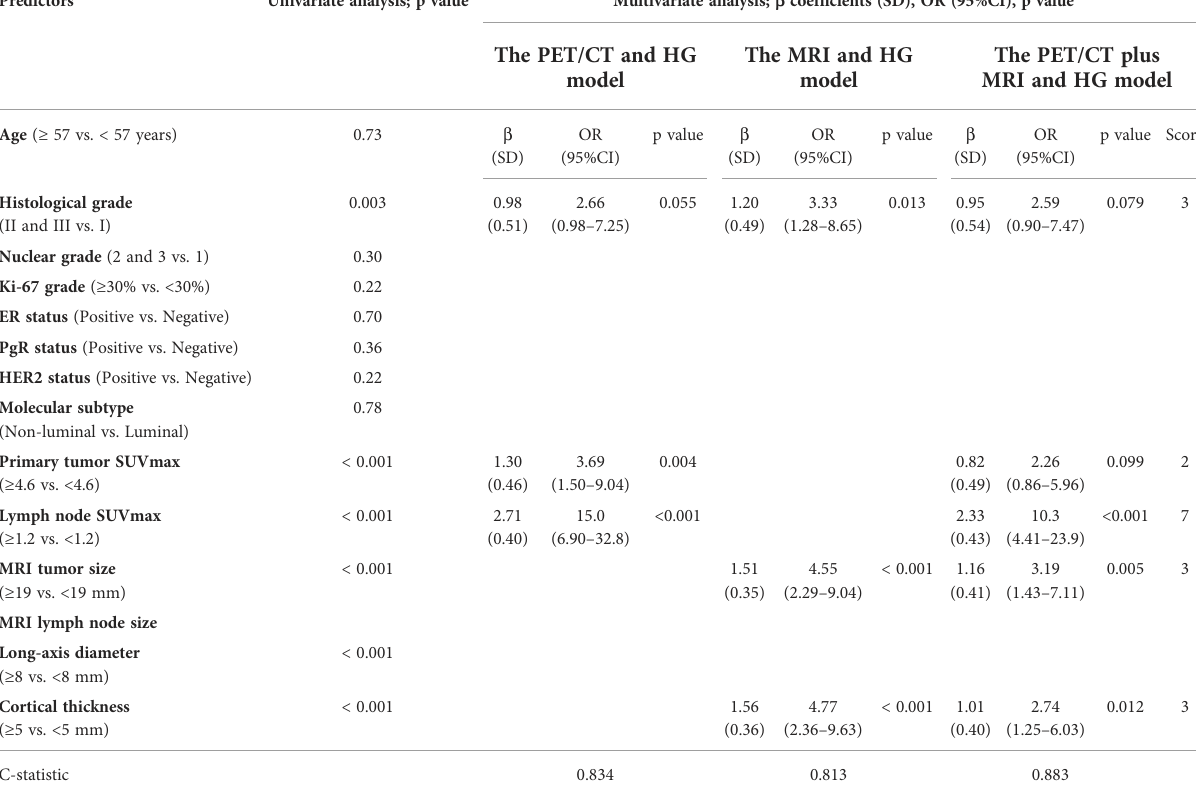
TABLE 2 Predictors of axillary lymph node macrometastasis in the PET/CT and histological grade, MRI and histological grade, and PET/CT plus MRI and histological grade models and score weights of the predictive variables in the PET/CT plus MRI and histological grade model.